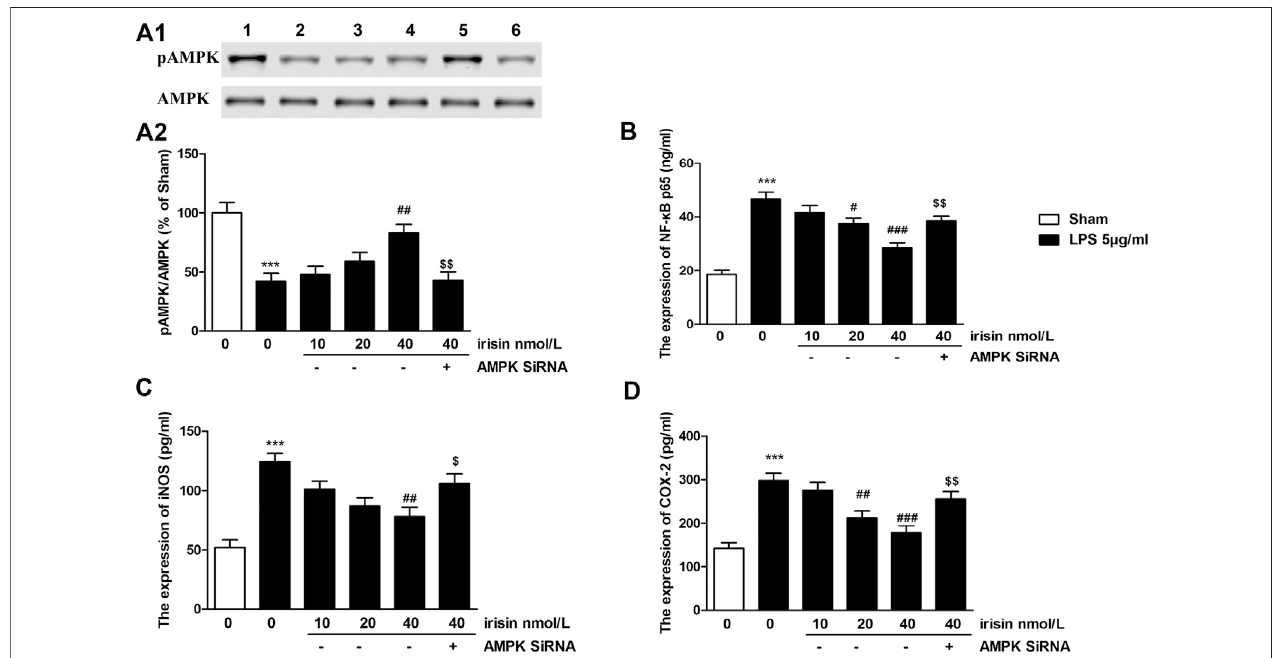
FIGURE5 |(A) Effectsofirisinon pAMPK expression in lipopolysaccharide (LPS)-challenged PC12 cells, and thequantitative analysis ofthe blots (*** p (cid:2) 0.00044, ## p (cid:2) 0.0025, $$ p (cid:2) 0.0029).blot1:control;2:LPS;3 – 5:irisin(dosesof10,20and40 nmol/L)+LPS;6:compoundC+irisin(40 nmol/L)+LPSgroup. (B) Effectsofirisin on NF- κ Bp65 expression in in LPS-treated PC 12 cells (*** p (cid:2) 0.000011, ### p (cid:2) 0.00021, $$ p (cid:2) 0.0026). (C,D) Effects of irisin on expressions of inducible nitricoxidesynthase (iNOS) ( *** p (cid:2) 0.000019, ## p (cid:2) 0.0015, $ p (cid:2) 0.037) and Cyclooxygenase-2 (*** p (cid:2) 0.000026, ### p (cid:2) 0.00043, $$ p (cid:2) 0.0074) in LPS-treated PC 12 cells. Data are presented as Mean ± SEM, n (cid:2) 5. *** p < 0.001 when compared with control group; # p < 0.05, ## p < 0.01 and ### p < 0.001 when compared with LPS group; $ p < 0.05 and $$ p < 0.01 when compared with irisin-treated LPS group.